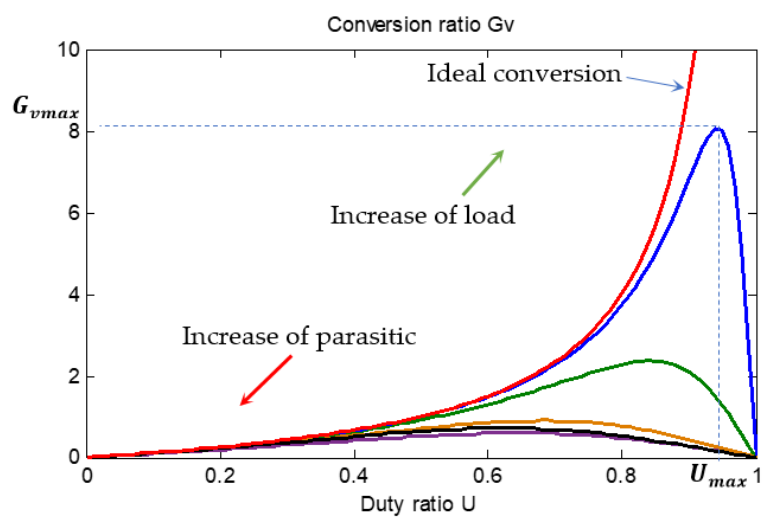
Figure 4. Conversion ratio versus resistance load and parasitic parameters.